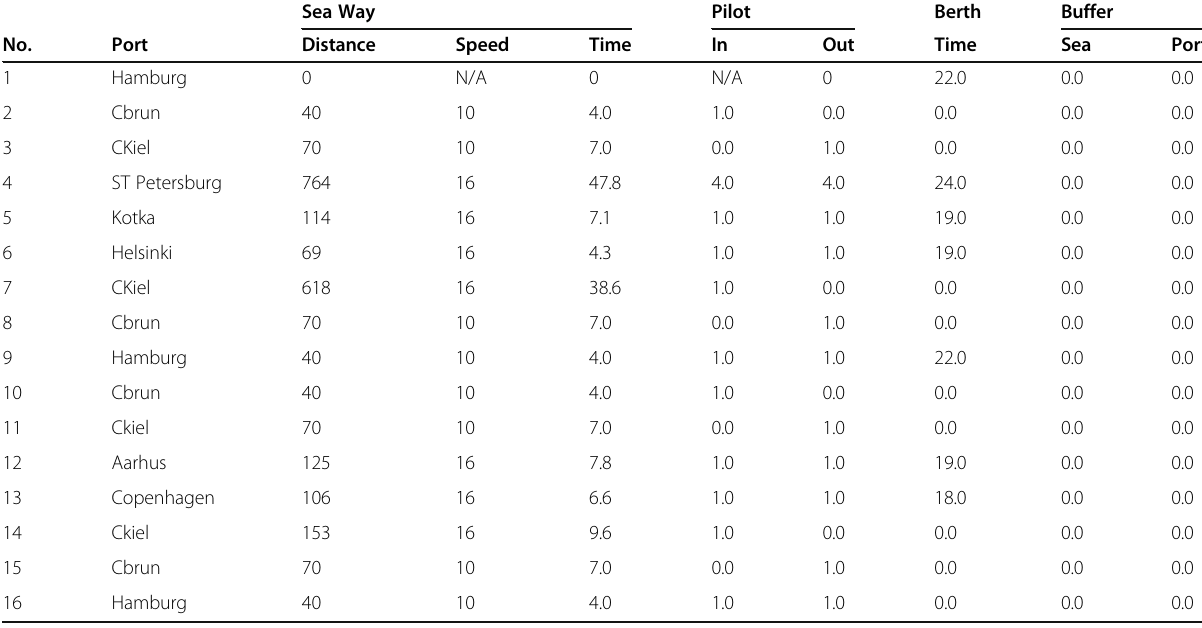
Table 4 Alternatives to connect Kotka with Russia and Denmark (Source: authors) Sea Way Pilot Berth No.